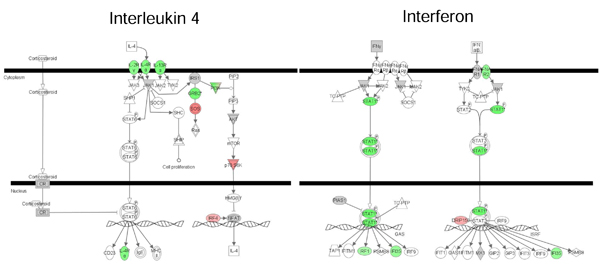
Canonical pathway underlines genes involved in inflammatory cytokines signalisation from the primary/secondary response comparison (PM8-MM8). We compared the secondary infection to the single ones. Green colour shows down regulated genes in the MM8 (secondary response) condition versus PM8 (primary response). Red colour shows up regulated genes in the MM8 (secondary response) condition versus PM8 (primary response).